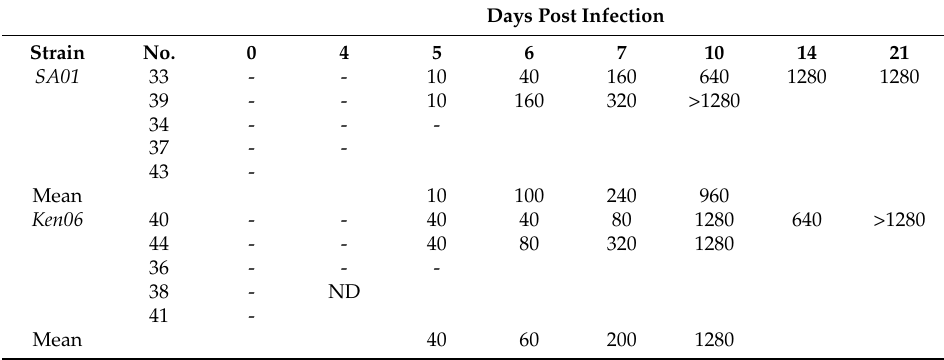
Figure 3. Development of the antibody response of individual calves infected with RVFV strains, SA01 (blue) and Ken06 (gray). Specific indirect ELISA shows the kinetics of total IgG antibody responses in sheep inoculated with wild-type RVFV strains, SA01 and Ken06: ( A ) RVFV N-ELISA; ( B ) RVFV Gn-ELISA. The dashed line indicates the calculated cut-off values (N-ELISA = 0.27; Gn-ELISA = 0.33). Table 4. Reciprocal plaque reduction neutralization test (PRNT 80 ) titers in calves infected with RVFV strains, SA01 and Ken06.